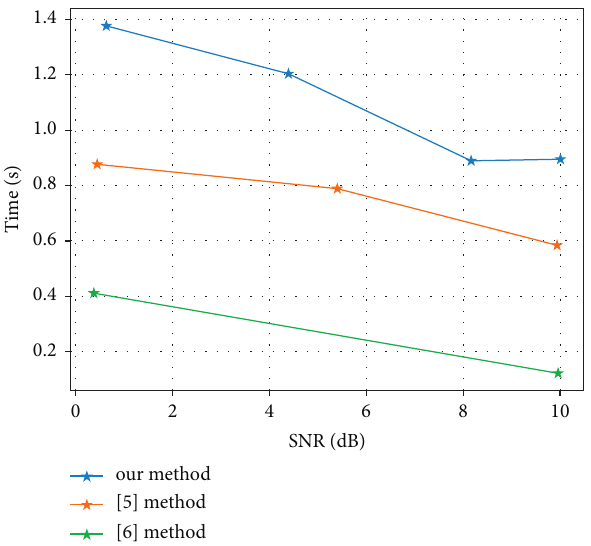
Figure 6: Time performance comparison.